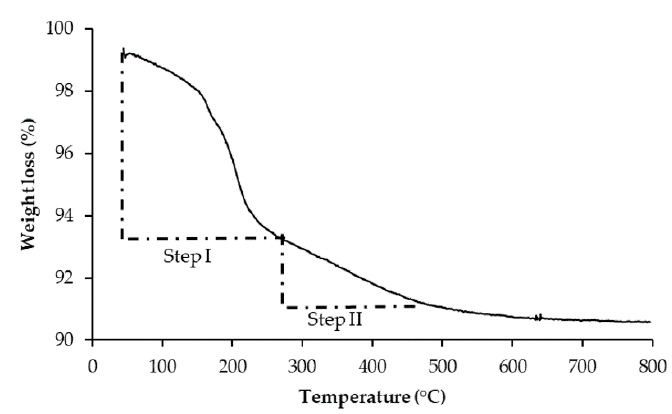
Figure 1. TG weight loss profile of 0.1Fe-TiO 2 photocatalyst.